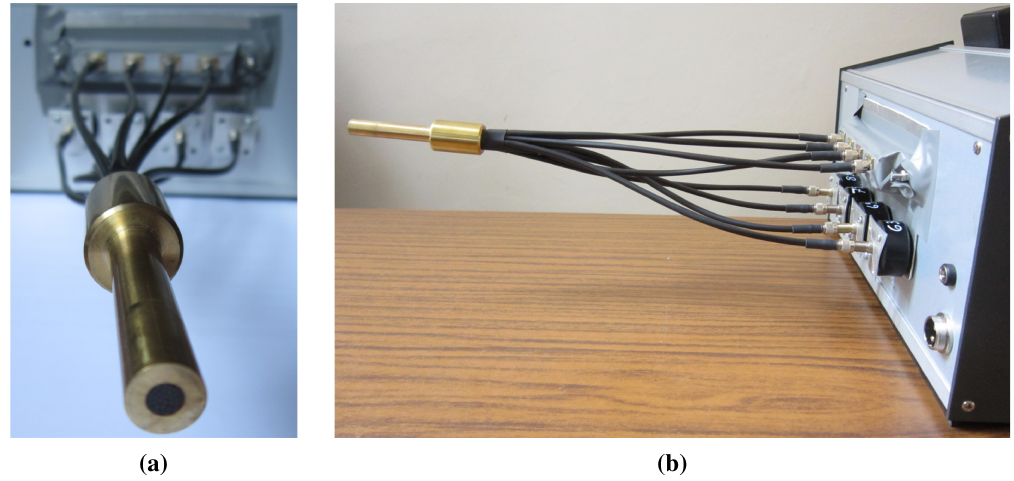
Figure 2. The customized quartz optical fiber: ( a ) front and ( b ) lateral